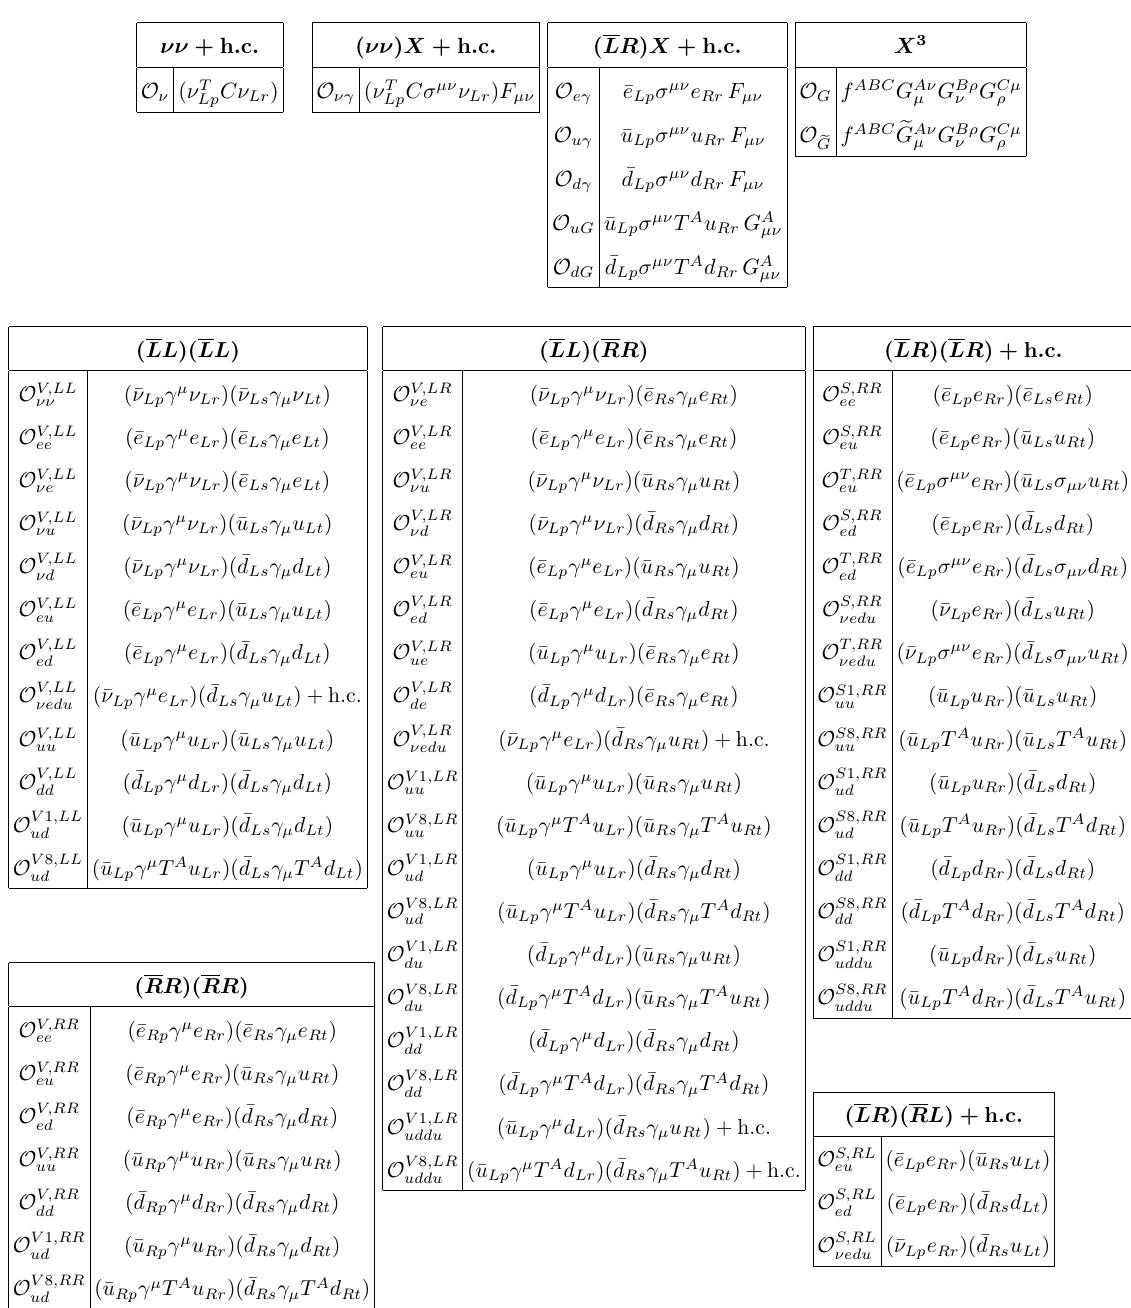
Table 1 . LEFT operators of dimension three and (cid:12)ve, as well as LEFT operators of dimension six that conserve baryon and lepton number, reproduced from ref.